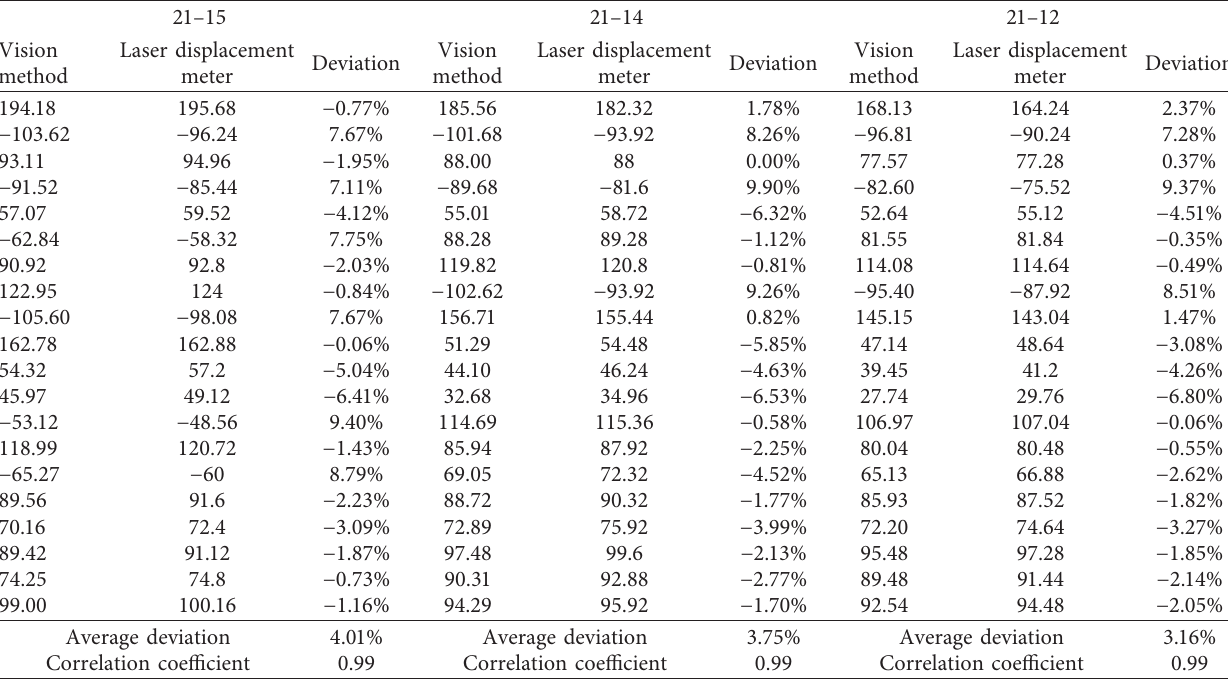
Table 2: Horizontal maximum displacement error and correlation coefficient of each floor under the working condition 21.